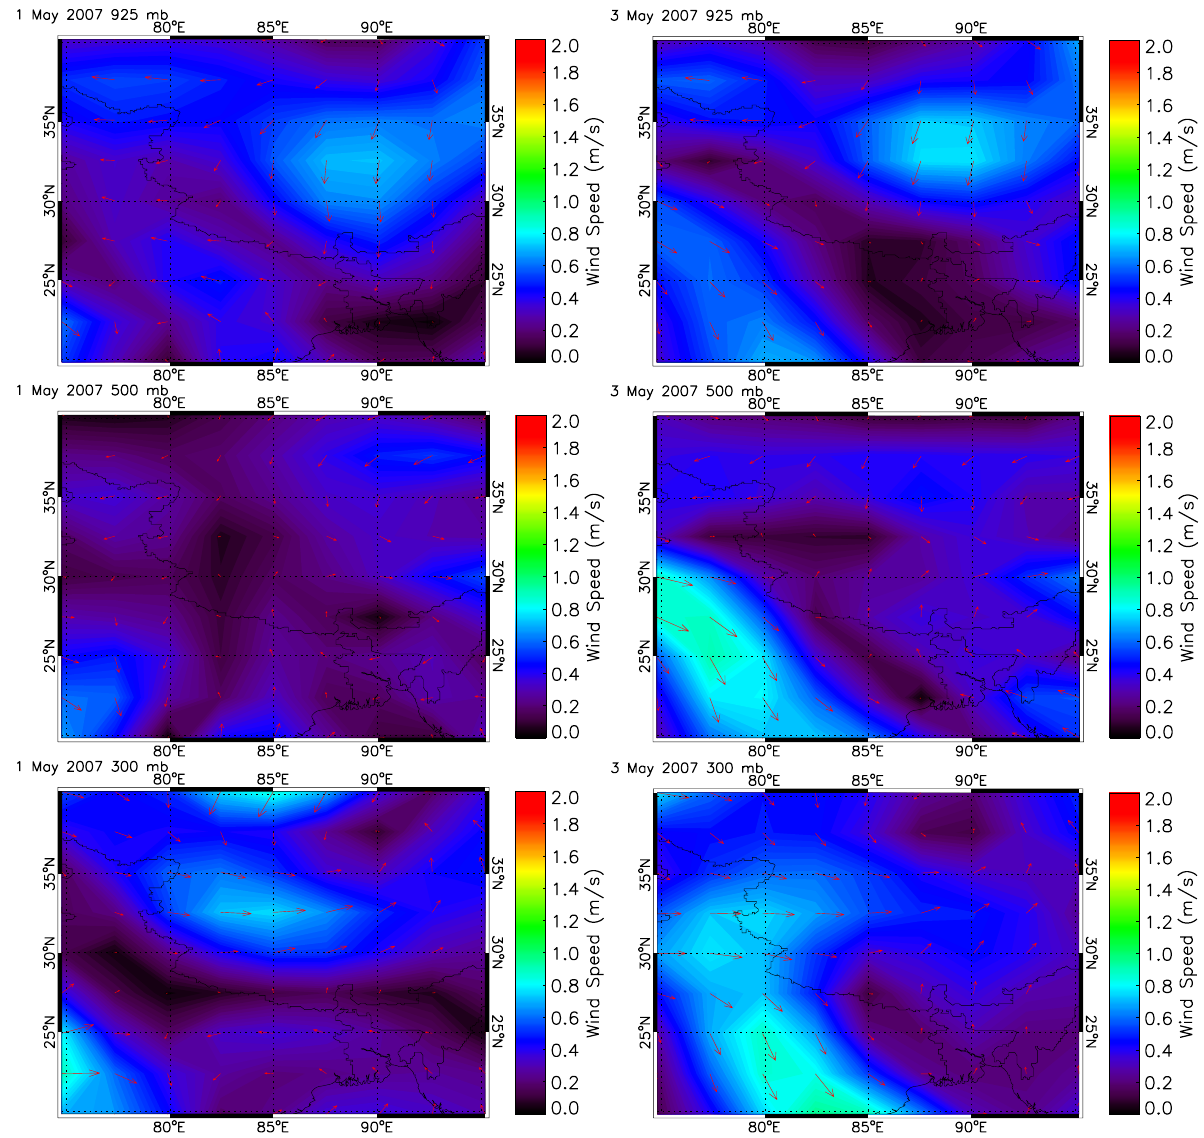
Fig. 5. The NCEP-reanalysis winds from 300mb to 900mb levels exhibiting very low winds for 3 and 8 May